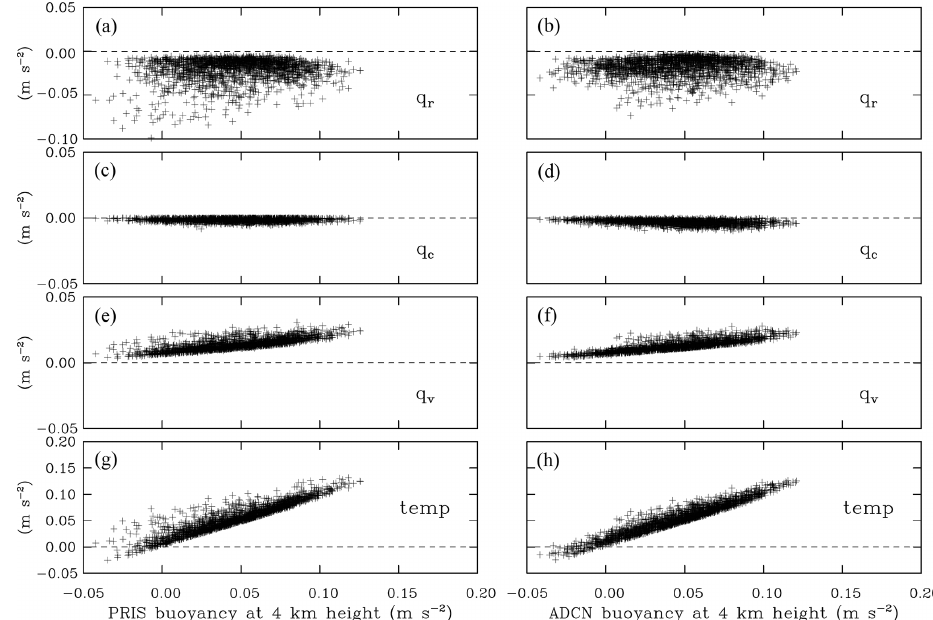
Figure 10. Like Fig. 8, but for all seven simulations of (a, c, e, g) PRIS and (b, d, f, h) ADCN from 2MOM ensemble. Only 5% of data points are